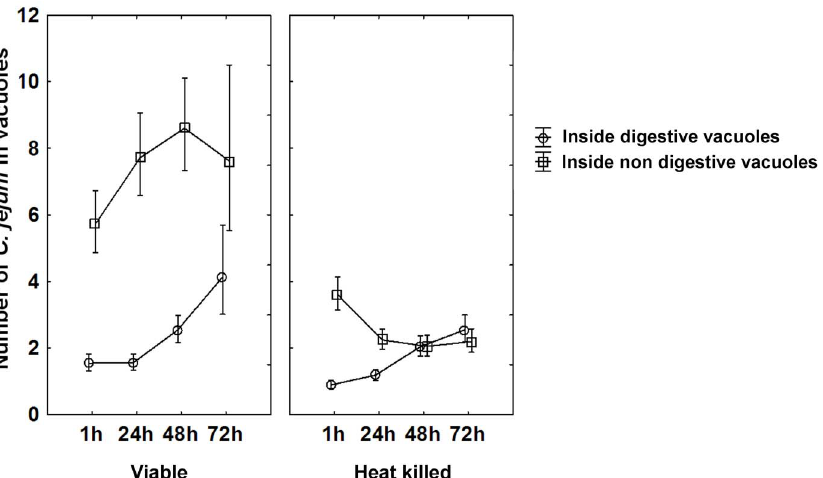
Figure 3. Intracellular localization of viable and heat killed C.jejuni in A.polyphaga . The number of viable and heat killed C. jejuni found inside digestive- (circles) and non digestive (squares) vacuoles are shown after 1 h, 24 h, 48 h and 72 h of co-incubation. Viable C. jejuni were found inside non digestive vacuoles to a significantly larger extent than heat killed bacteria. This difference was not observed inside digestive vacuoles. Data for all time points are based on two to three independent experiments, except for viable C. jejuni and A. polyphaga at 72 h that was based on one experiment. Mean 6 95 confidence interval.